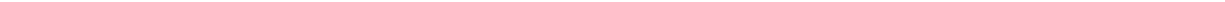
Fig. 1 Steady-state PM localisation of Src and Fyn requires vesicular traf fi c from the RE and Golgi. a Confocal images showing the steady-state localisation of mCitrine fused Src and Fyn in HeLa cells co-expressing the PM marker mCh-tK-Ras, and stained with antibodies against the RE compartment marker, Rab11a (see also Supplementary Fig. 2a). Dot plot depicts Pearson ’ s correlation coef fi cient for Src and Fyn with either the PM marker or the RE marker ( n > 60 cells per condition from two independent experiments, data are mean ± SD). b HeLa cells co-expressing the dominant-negative mutant form of Rab11 (Rab11 S25N -BFP) and either Src-mCit or Fyn-mCit (see also Supplementary Fig. 2b). Dot plot depicts the percentage of the area of Src or Fyn pixels staining internal membrane structures that overlapped with the Rab11 S25N -BFP pixels ( n > 40 cells per condition, data are mean ± SD, **** P < 0.0001, Student ’ s t -test). c Confocal micrographs of HeLa cells expressing Src-mCit and Fyn-mCit, transfected with Rab11a/b targeting siRNA or non-targeting siRNA control nucleotides. d Representative western blot showing Rab11a levels of transfected cells and the Tubulin-loading control ( n = 3 independent experiments). e HeLa cells co-expressing the Golgi marker (GalT-mCer) and Src-mCit or Fyn-mCit, either cultured at 37 °C ( left panels ) or 20 °C ( right panels ) for 24 h, at which point cells were fi xed. Graph depicts the percentage of the area of Src or Fyn pixels staining internal membrane structures that overlapped with the GalT-mCer pixels ( n > 40 cells for each condition from two independent experiments, data are depicted as a box and whiskers plot , showing the median and the full range of the measurements. *** P < 0.001; **** P < 0.0001; n.s., not signi fi cant, as determined by Student ’ s t -test). f Time series of HeLa cells co-expressing the Golgi marker (GalT-mCer) and Fyn-mCit, treated with the 25 μ M of the APT inhibitor palmostatin-M (Pal). The plot to the right depict the integrated intensity of Fyn-mCit at the Golgi over the integrated intensity over the whole of the cell ( n = 17 cells from two independent experiments; data are mean ± SEM). Scale bars , 10 μ